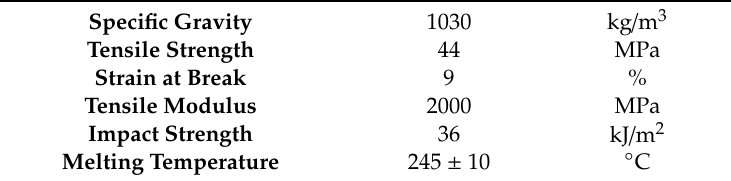
Table 1. Selected properties of the acrylonitrile butadiene styrene (ABS) used [29].